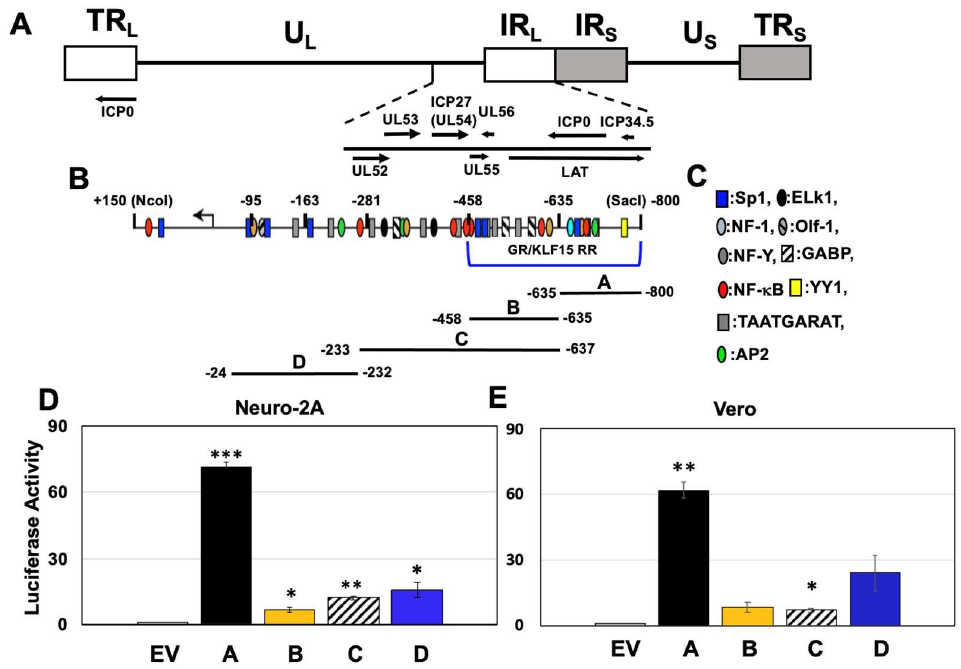
Figure 1. Location of ICP0 gene and promoter/enhancer sequences within the IR L and TR L repeats of the HSV − 1 genome. (Panel A ): Schematic of HSV-1 genome. Unique long (U L ) and unique short (U S ) segments are flanked by the long internal or terminal repeats (IR L and TR L : white rectangles) and short internal or terminal (IR S and TR S : gray rectangles). Location of known genes in IR L , including ICP0, are shown. A copy of ICP0 is also present in the TR L . ( Panel B ): Schematic of ICP0 promoter, and location of potential transcription factor binding sites ( Panel C ) relative to the start site of ICP0 mRNA (arrow). Four fragments ( A – D ) were used in this study and were cloned upstream of the pGL4.24[luc2/minP] firefly luciferase reporter plasmid. Neuro-2A ( Panel D ) or Vero ( Panel E ) cells were transfected with 0.5 ug of the denoted CRM constructs and a Renilla luciferase plasmid (0.05 ug). At 48 h after transfection, dual luciferase activity was performed. Fold activation was calculated relative to pGL4.24[luc2P/minP] or empty vector (EV) for each construct. Results are the mean of three experiments, and error bars indicate standard error. The *, ** and *** denote a significant difference of p < 0.05, p < 0.005 and p < 0.0005 respectively compared to the EV luciferase activity as determined by Student’s t-test. Statistical analysis was performed as described in Materials and Methods.